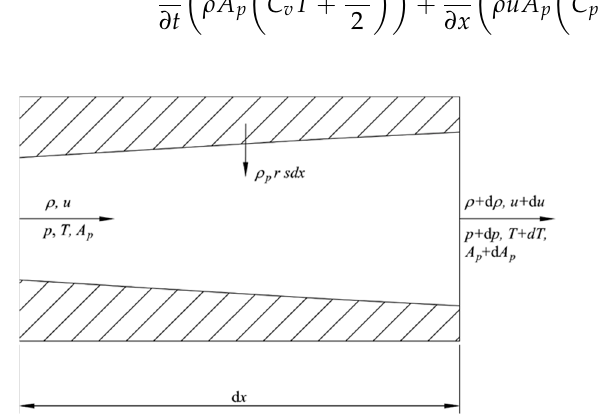
Figure 1. Schematic of the control volume.